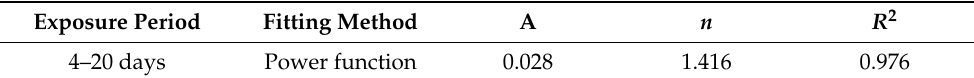
Table 2. Corrosion weight loss fitting results of Q235 low-carbon steel samples exposed to acceler- ated corrosive environments.